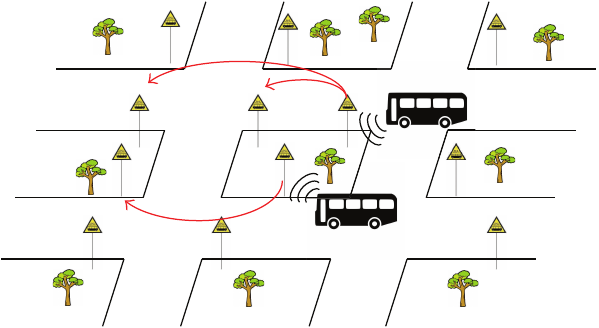
Figure 2: The diagram of our